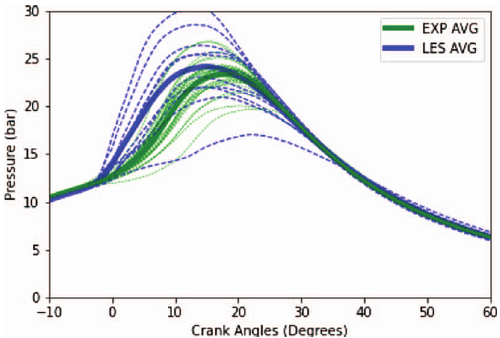
Fig. 11. TFM and LESI ignition model: peak in-cylinder pressure for LES (blue) and experiments (green). Individual cycles are denoted by the dashed lines and the ensemble average is denoted by bold